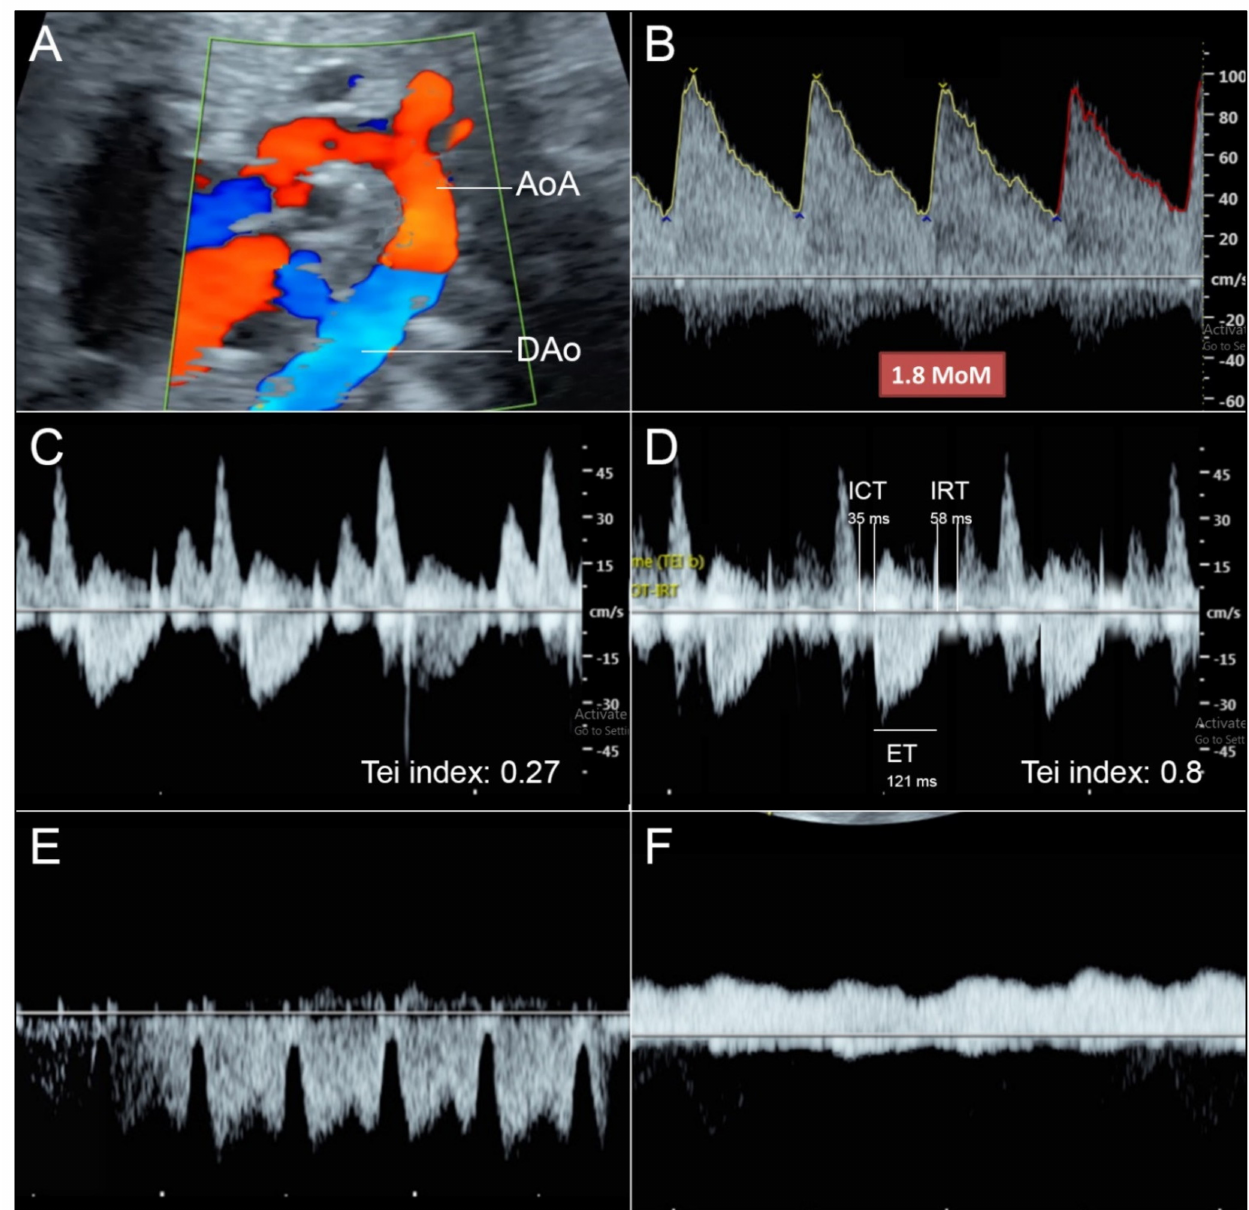
Figure 2. ( A ) Sagittal and cross-sectional scans of the arch view show reversed flow in AoA; ( B ) Markedly increased middle-cererbral artery peak systolic velocity; ( C ) Normal Tei index of the LV; ( D ) Markedly increased Tei index of the RV; ( E ) Ductus venous waveforms show very low a-wave, indicating increased preload; ( F ) Umbilical venous pulsations indicating high preload propa- gating cardiac pulse through ductus venosus. (AoA: aortic arch; DAo: descending aorta; FFo: flap of foramen ovale; LV: left ventricle; RV: right